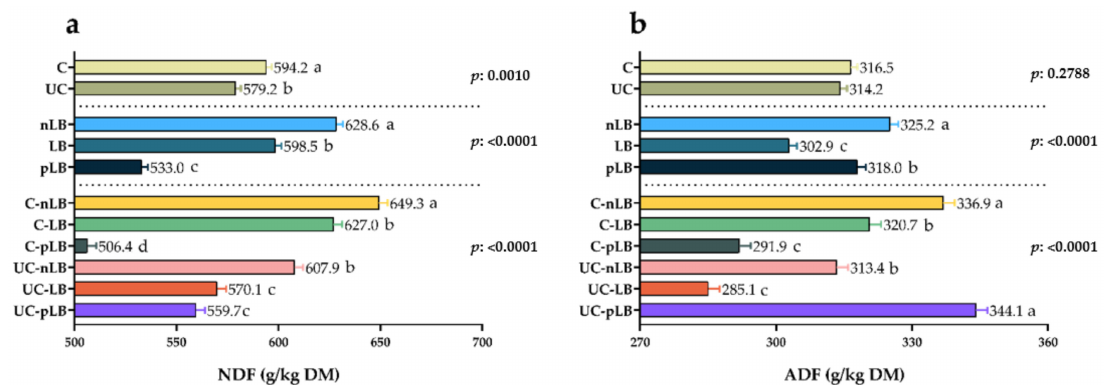
Figure 3. Effect of urea-treatment and preactivation of L. buchneri on the cell wall component of corn silages. Changes in the content of neutral detergent fiber [NDF, ( a )], and aciddetergent fiber [ADF, ( b )] of corn silages. A dotted line separates the urea treatment, the L. buchneri forms, and their interaction. C: corn silages not treated with urea, UC: corn silages treated with 1.0% urea on dry matter basis, C-nLB: corn silages not treated with urea and uninoculated with L. buchneri , C-LB: corn silages not treated with urea and inoculated with L. buchneri , C-pLB: corn silages not treated with urea and inoculated with preactivated L. buchneri , UC-nLB: corn silages treated with urea and uninoculated with L. buchneri , UC-LB: corn silages treated with urea and inoculated with L. buchneri , UC-pLB: corn silages treated with urea and inoculated with preactivated L. buchneri , DM: dry matter, U: urea treatment, LB: L. buchneri forms, U × LB: interaction between urea treatment and L. buchneri inoculation. Factors that are statistically significant are highlighted in bold ( p < 0.05). Values with different letters (a–c) in each graph are statistically different ( p <